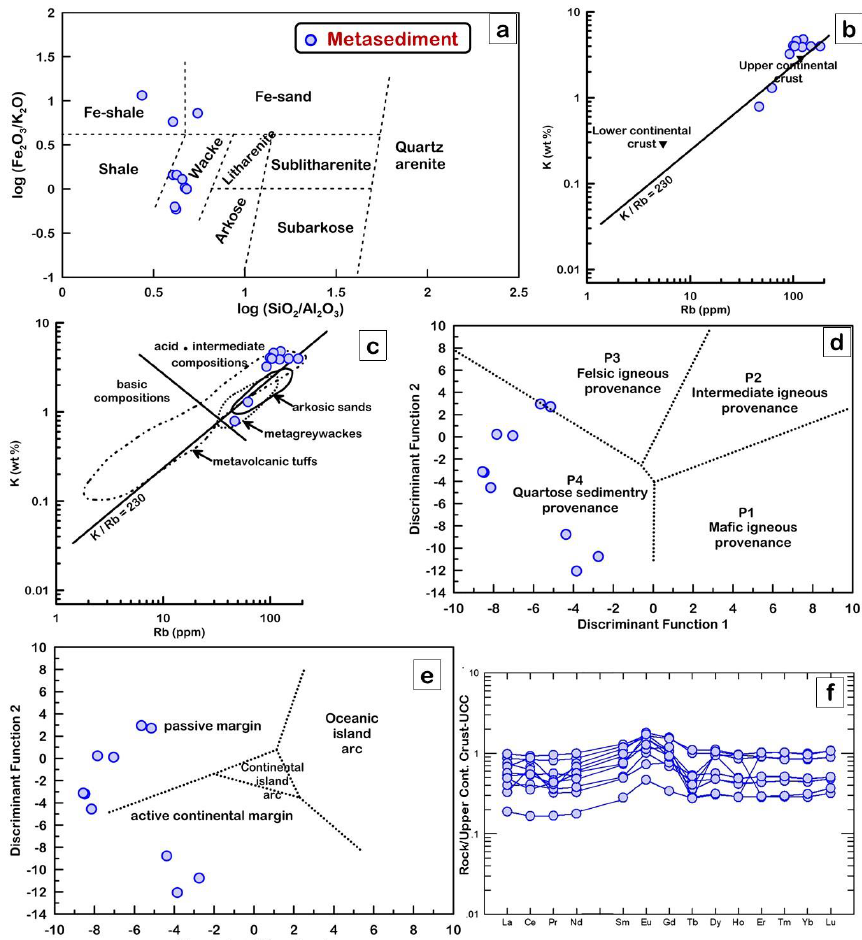
Figure 10. Geochemical classification diagrams of metasediments: ( a ) log(Fe 2 O 3 /K 2 O) − log(SiO 2 /Al 2 O 3 ) diagram after Herron [36]. ( b , c ) K − Rb diagrams after Floyd and Leveridge [38]. Fields of unmetamorphosed arkosic sands after van de Kamp et al. [39], low − grade metagreywackes after Condie et al. [40] and Caby et al. [41], and higher-grade metavolcanic tuffs after van de Kamp [42]; ( d ) plot of samples in discriminant functions F1 vs. F2 (provenance fields are after Roser and Korsch [43]; ( e ) plot of discriminant scores along Function 1 vs. 2 after Bhatia [44]; ( f ) upper continental crust (UCC) − normalized REE patterns [37].